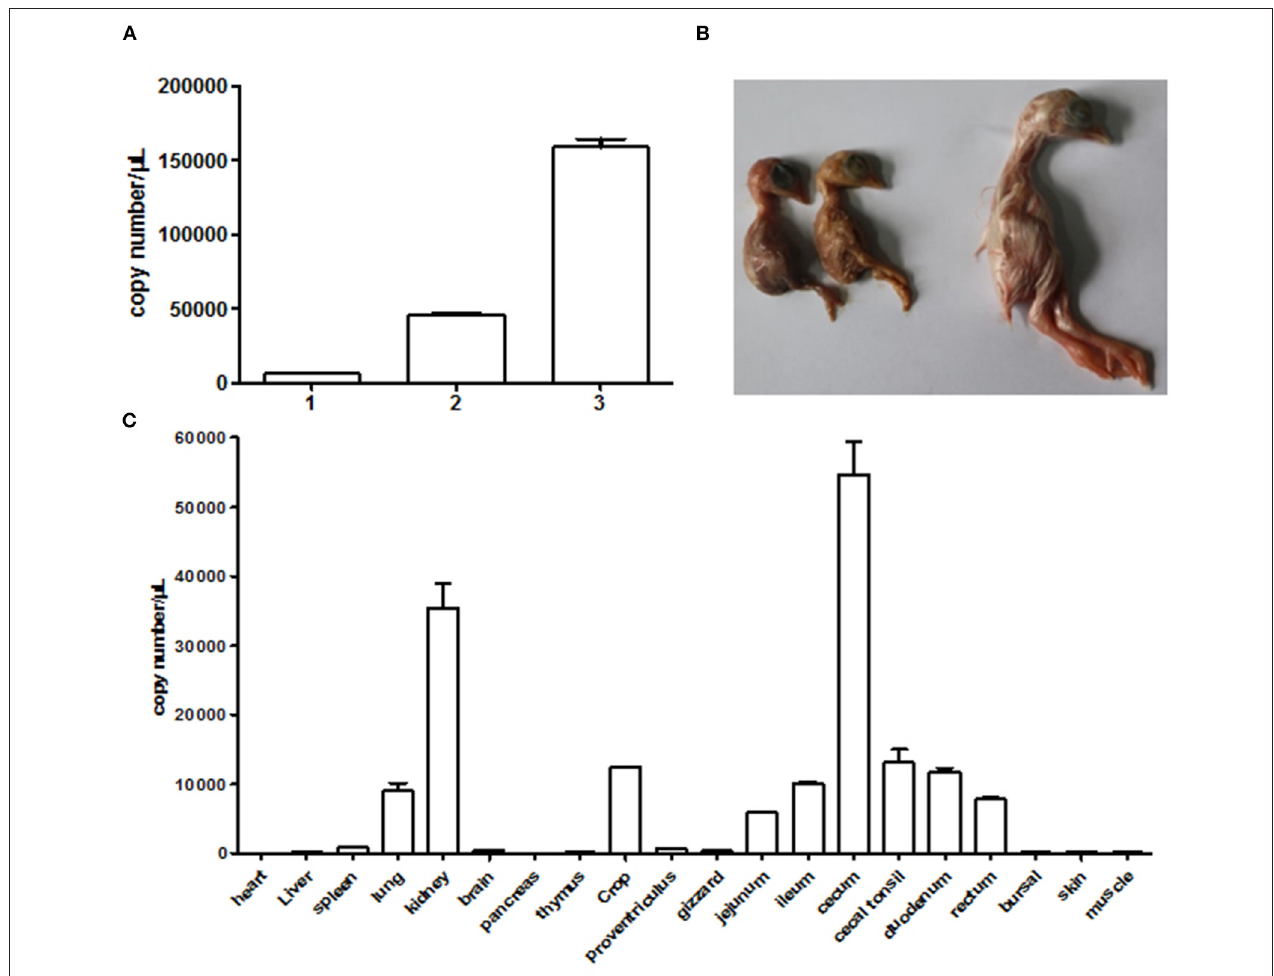
FIGURE 4 | Infection experiments with CAstV NJ1701 in chicken embryos. (A) Viral gene copy numbers of allantoic fluid in embryos of different passages. The copy numbers of passages 1, 2, and 3 were 6.00 × 10 3 , 4.58 × 10 4 , and 1.59 × 10 5 , respectively. Data were expressed as mean ± SD from three independent experiments. (B) Ten days after infection at passage 3, 17-day-old infected embryos with growth depression (two of the left) were observed. The uninfected embryo (right) was used as control. (C) The viral copy numbers of different visceral organs from chicks at hatch in infected group were determined using qRT-PCR. Data were expressed as mean ± SD from three independent